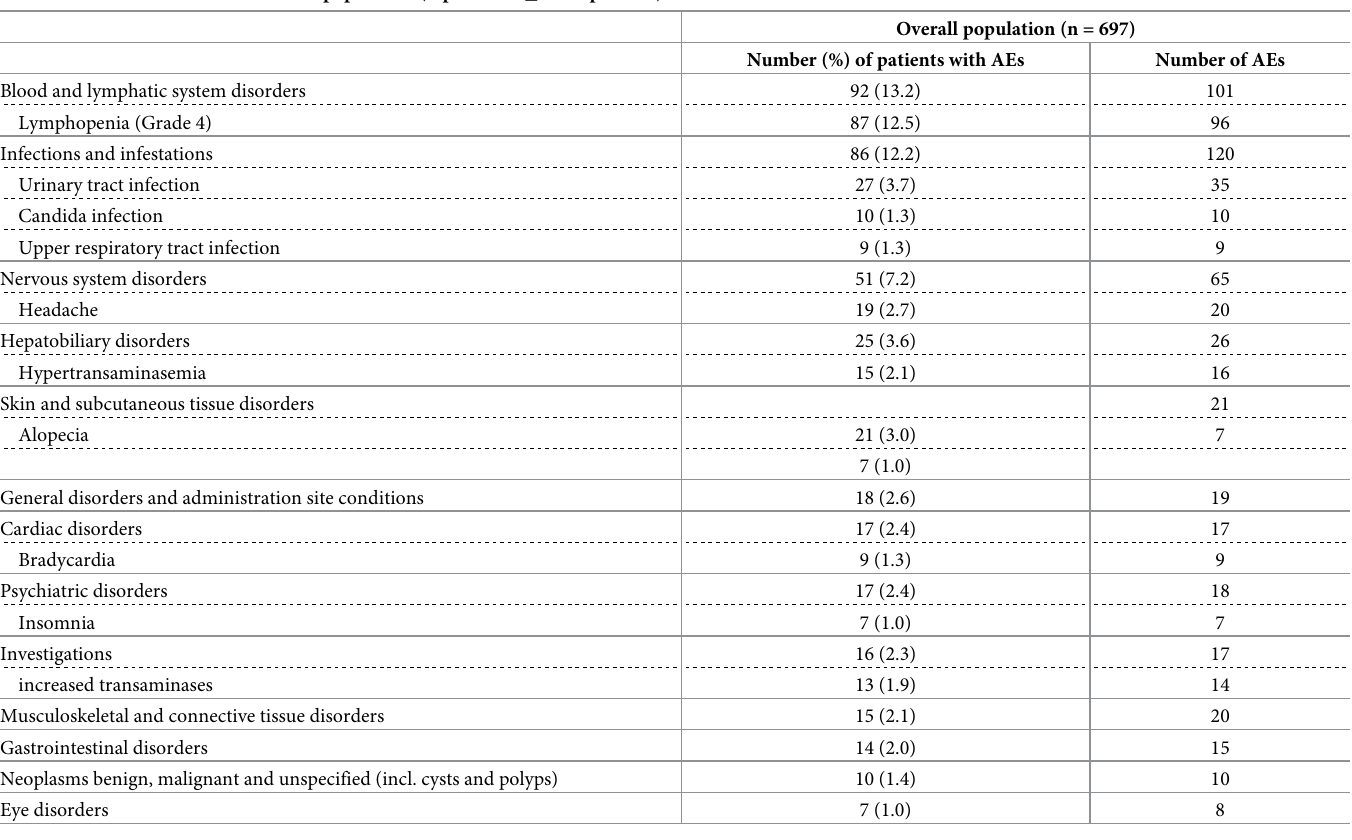
Table 3. Adverse events for the overall population (reported in � 1% of